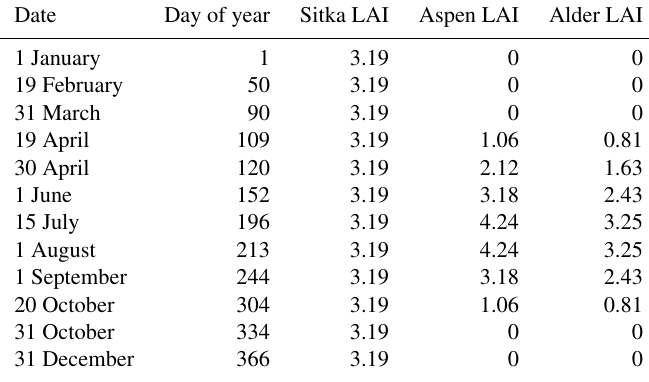
Table 2. Seasonal time course of leaf area index (LAI) for estimating annual VOC emissions for different species plots at East Grange, Fife, Scotland, using MEGAN 2.1